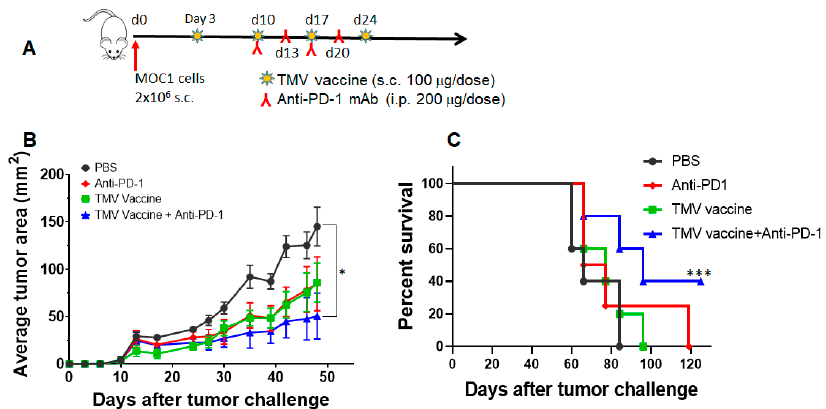
Figure 4. TMV vaccine + anti-PD-1 mAb combination inhibits MOC1 tumor growth. ( A ) C57BL / 6 mice ( n = 5) were challenged with 2 × 10 6 MOC1 cells (day 0) s.c. on the right flank and they were vaccinated with four doses of 100 µ g of TMV vaccine weekly s.c. on the left flank starting on day 3. Rat anti-mouse PD-1 mAb (200 µ g / dose) was administered i.p. on d10, d13, d17, and d20 (inverted red Y). ( B ) Tumor size and ( C ) survival are shown. Values are mean ± SD and Student’s t-test between PBS and combination group. Log-rank (Mantel–Cox) test was used for determining the significance of the difference in the survival of mice. * p < 0.05, *** p < 0.001.